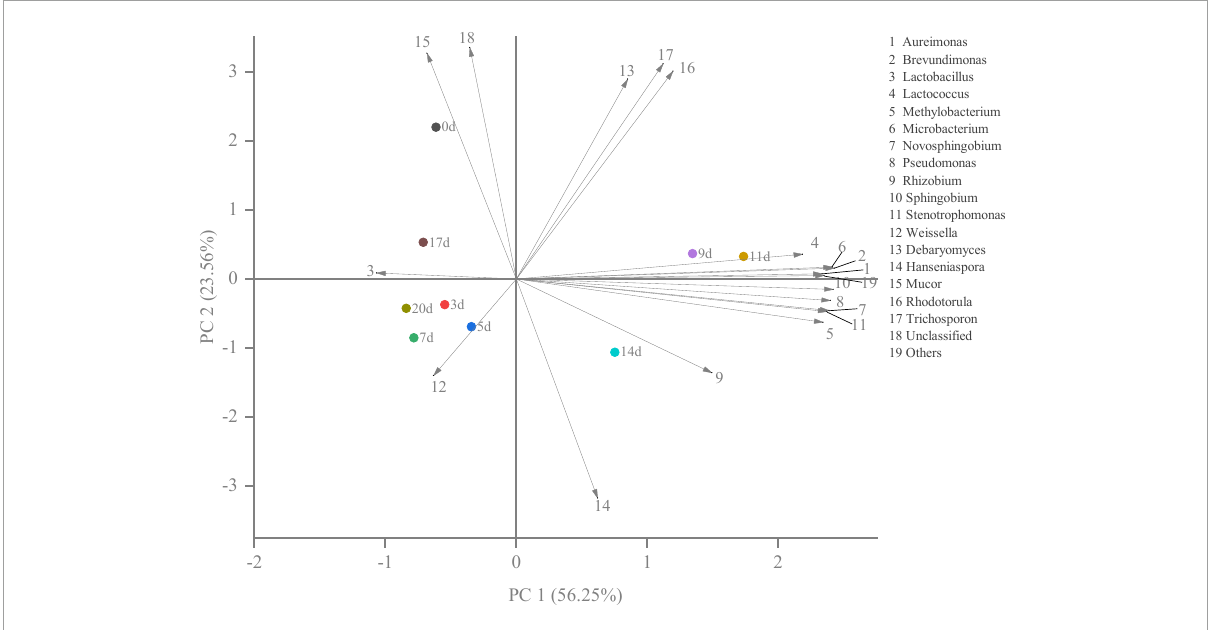
FIGURE3 The results of principal component analysis (PCA) showed the correlation between microorganisms and fermentation time during the production of fermented minced peppers.